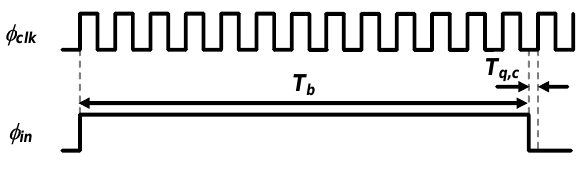
Figure 4. Timing diagram of the proposed TDC in mode A.